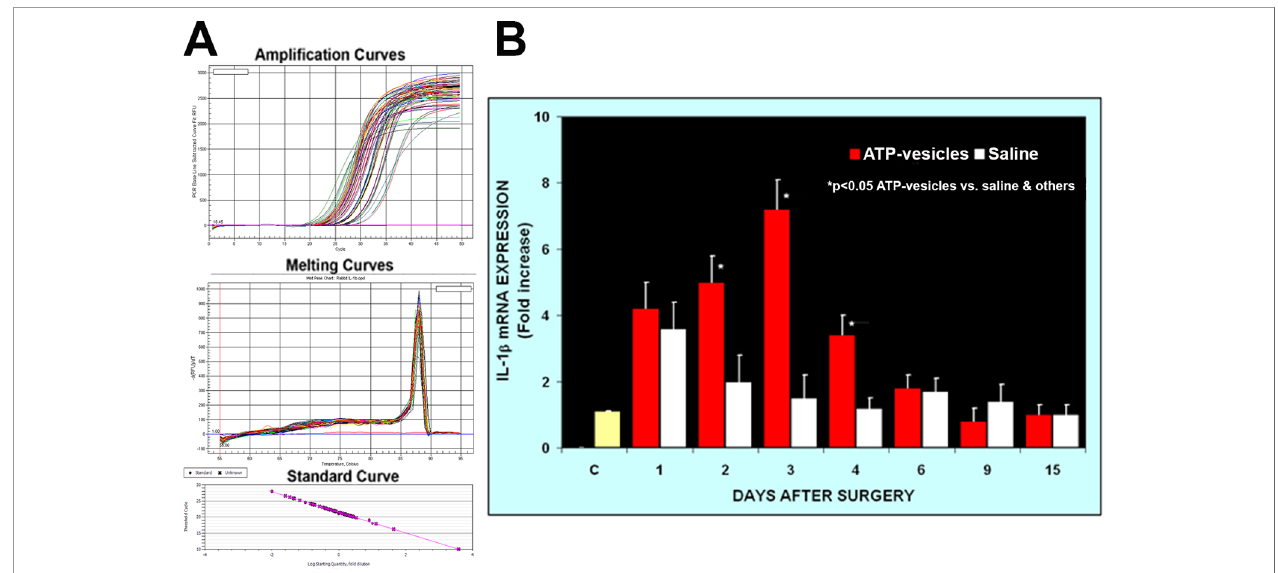
FIGURE 2 | Real-time PCR comparison of IL-1 b expression in wound tissues of ATP-vesicle – treated (study) and the saline treated (control) groups. (A) represents the ampli fi cation curves, melting curves, and standard curve of real-time PCR and (B) shows their quantitative fold changes indicating higher expressions from day 1 to day 4 by ATP-vesicles. Data shown are the mean ± SD of four to six different wound tissues, with triplicate assays for each sample. Normal rabbit ear skin was used as a baseline control (C). *Signi fi cantly different when compared with saline-treated control group and the baseline control, p <